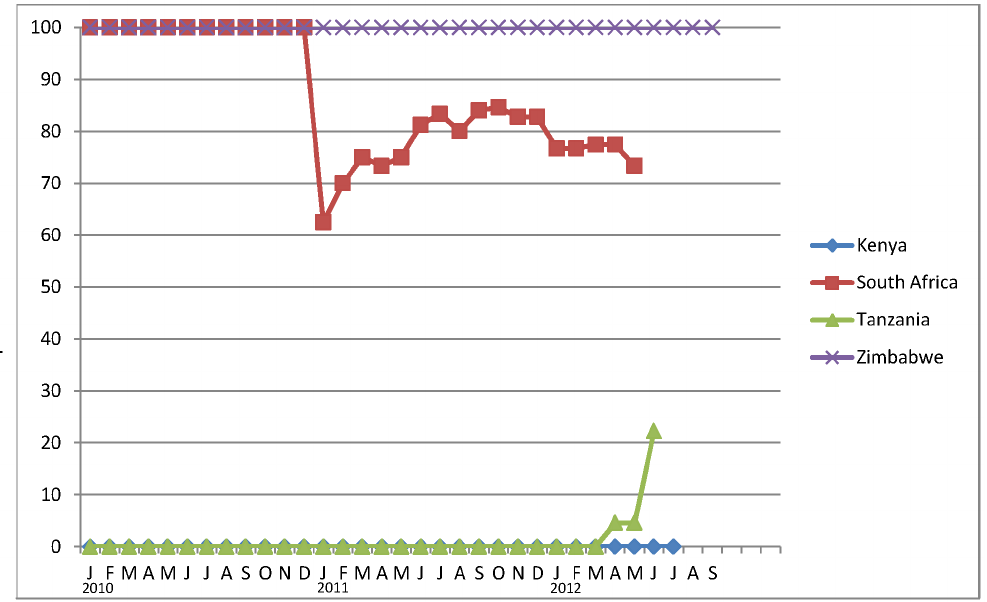
Figure 3. Proportion of VMMC sites using pre-packaged kits with consumables and disposable instruments, January 2010 – mid- 2012. The number of sites on which these data are based varies markedly by month over the observation period, as shown in Figure 1.